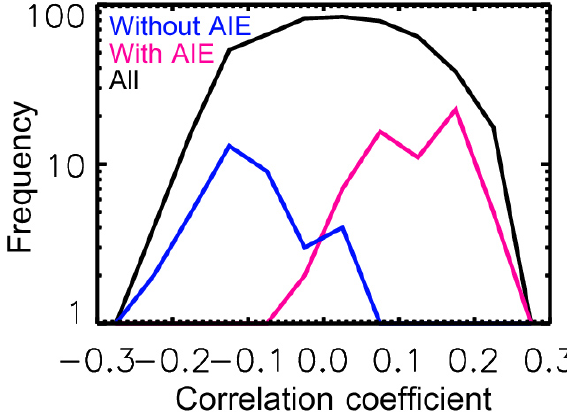
Figure 9. Histogram of the correlation between the spatial distri- bution of CMIP5 ensemble surface wind trend and the reanalysis surface wind trend over 1982–2008. The histogram represents 500 correlations, each based on the average surface winds of 3 randomly sampled CMIP5 models (black). The blue histogram shows ensem- bles that only contain models with no aerosol indirect effect (AIE) representation and the magenta distribution only those that do con- tain a parameterization for the aerosol indirect